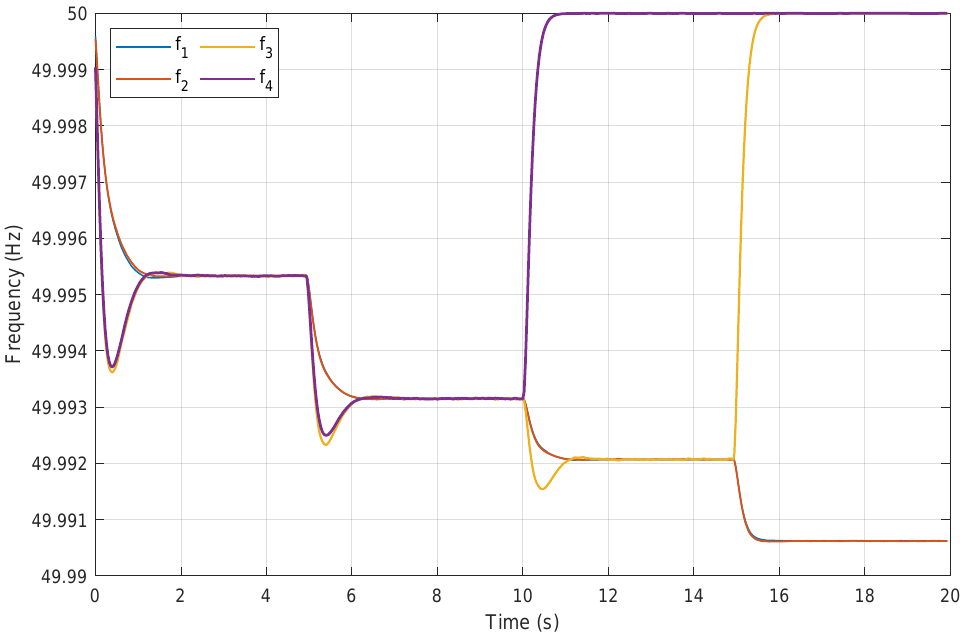
Figure 8. Conventional droop control strategy performance: Frequency regulation. In order to response to load and generation changes and guarantee proportional power sharing between IDGs, the frequency value deviates from the nominal value (50Hz) proportionally to the active power demand. That means that using this conventional technique exists an implicit trade-off between frequency regulation and power sharing